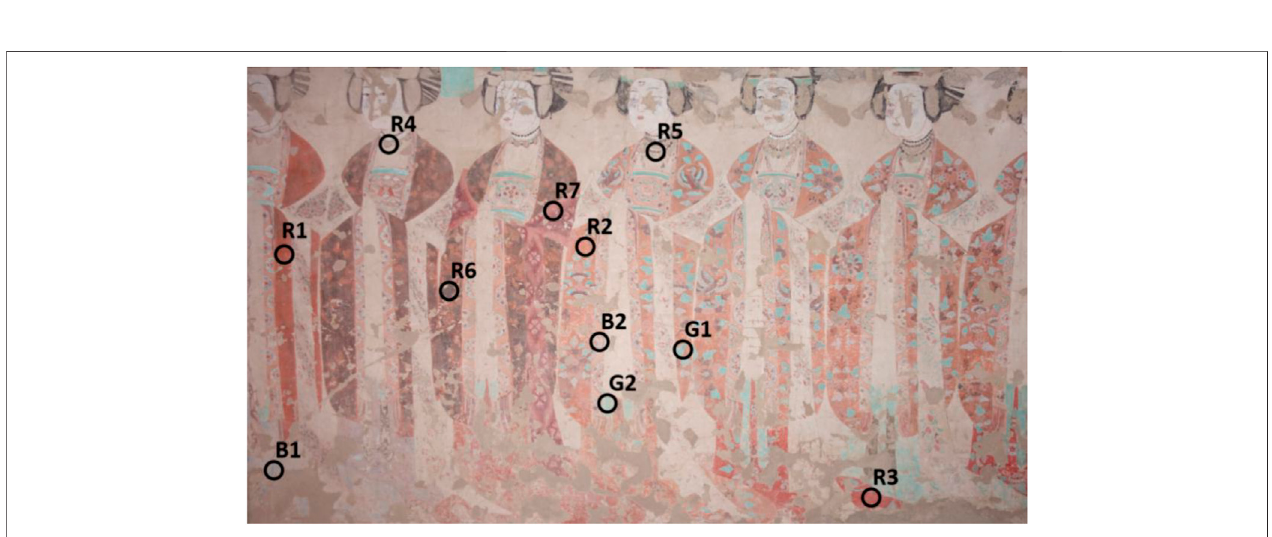
FIGURE 2 | Schematic and imaging of the portable laser-induced breakdown spectroscopy (LIBS) setup.